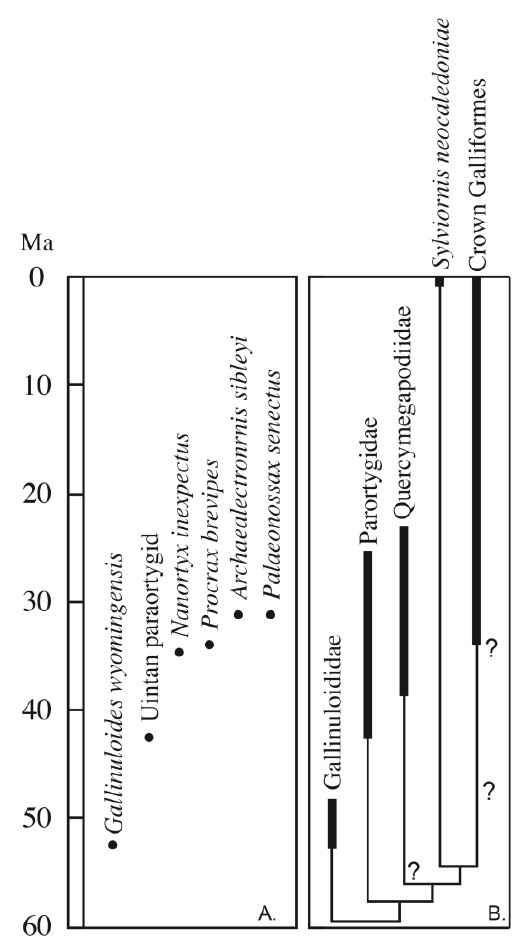
Figure 1. Phylogeny and temporal distribution of pangalliforms. ( A ) Temporal distribution of non-crown group pangalliforms in North America; ( B ) phylogeny and temporal distribution of Cenozoic pangalliforms with a focus on non-crown lineages [2,11]. Question marks indicate fossils possibly belonging to the lineage (see text for details).